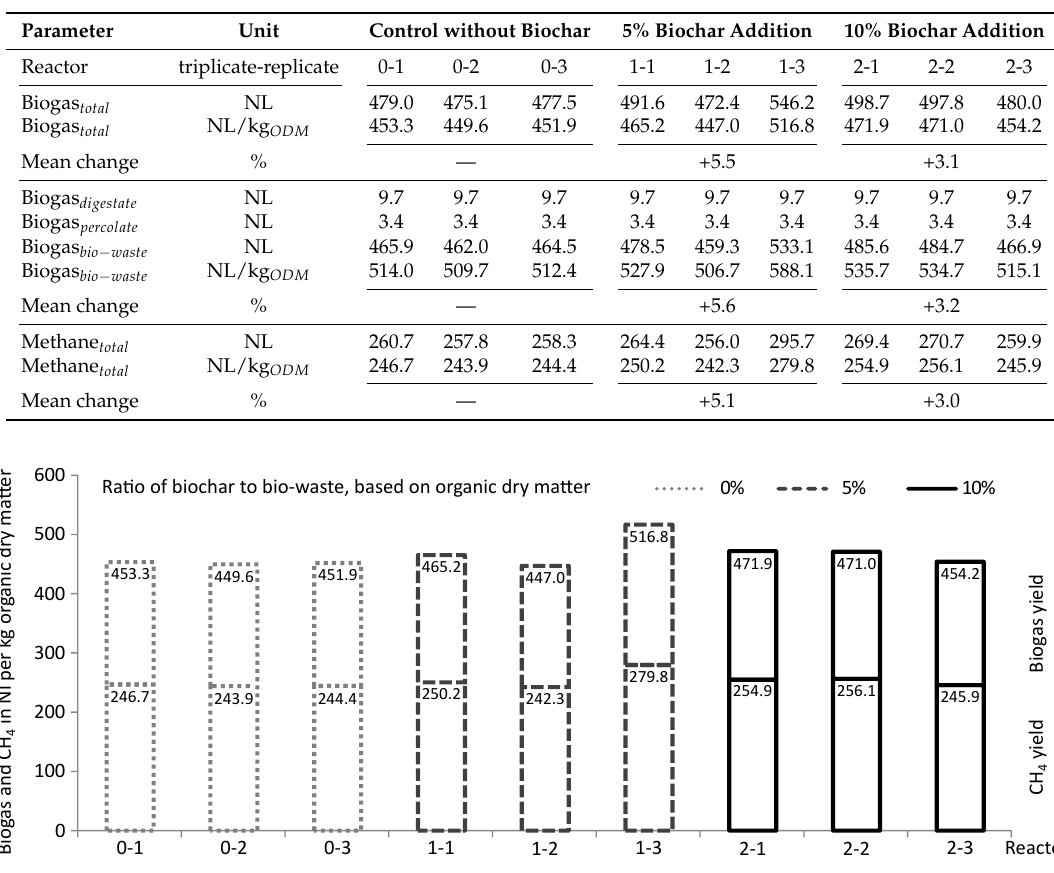
Table 1. Biogas and methane (CH 4 ) yields in total and per organic dry matter (ODM).